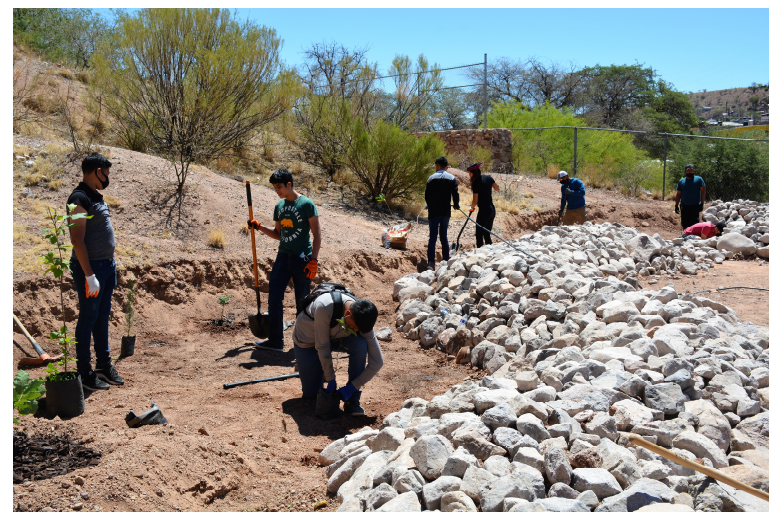
Figure 4. GI implementation at the Secundaria #3 in Nogales, Sonora (credit: Lara-Valencia).